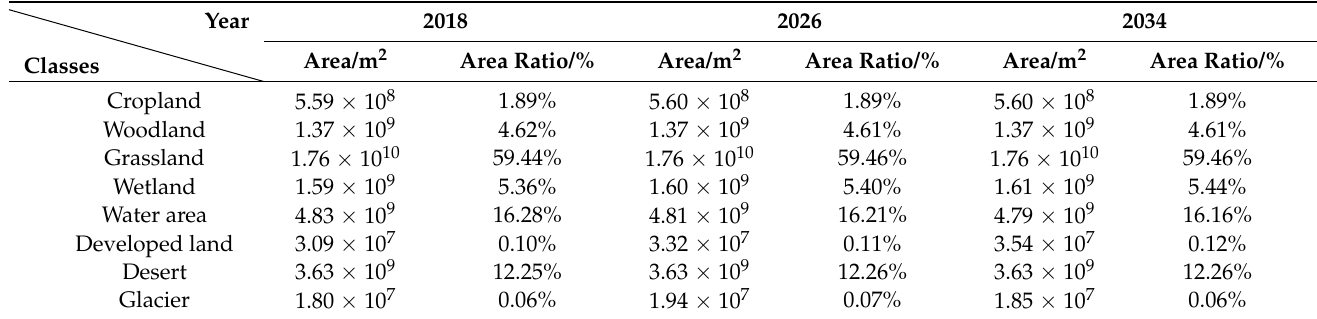
Table 7. LULC area values for the period 2018–2034 in the QLB (m 2 ).